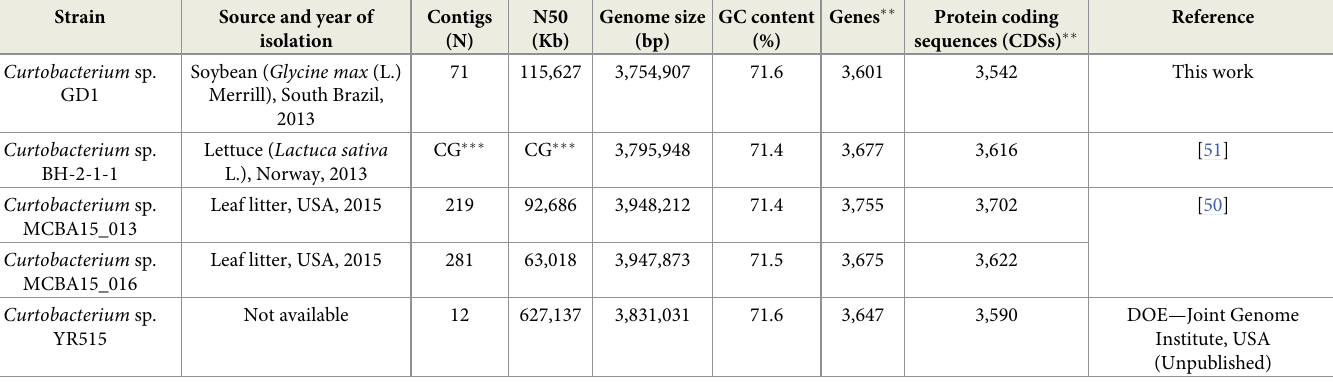
Table 2. Genome sequence features of Curtobacterium sp. GD1 and related Curtobacterium spp. strains �